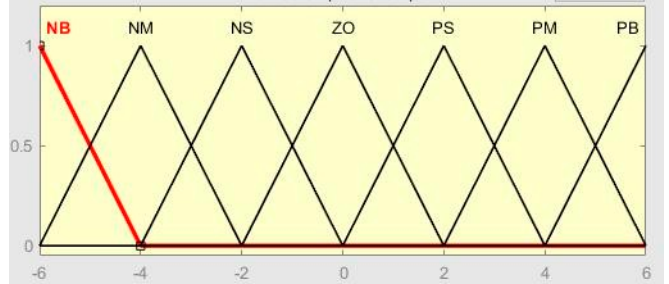
Figure 6. E and Ec membership function.